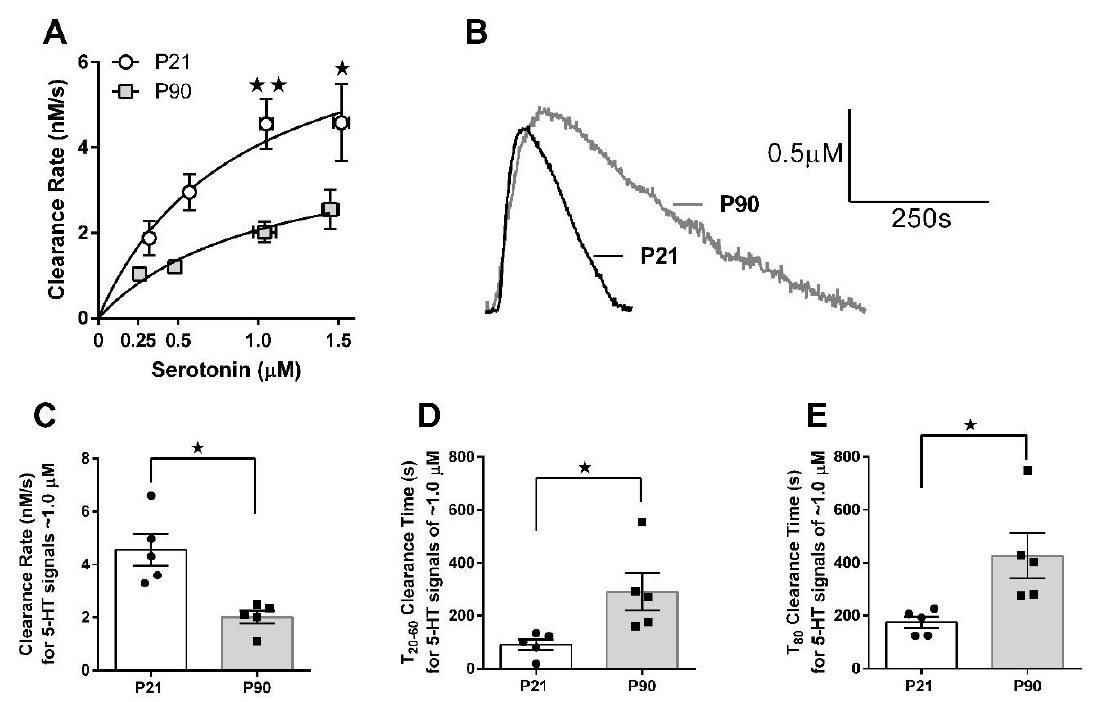
Figure 2. Juvenile mice clear serotonin faster from extracellular fluid in CA3 region of hippocampus than adult mice. ( A ) Serotonin clearance rate as a function of increasing extracellular serotonin concentration. Serotonin was intrahippocampally applied to obtain signals with amplitudes of approximately 0.25, 0.50, 1.0 and 1.5 µ M. Horizontal error bars represent variance (S.E.M) in signal amplitudes achieved. Vertical error bars are S.E.M. for clearance rate. Where error bars are not visible, they are obscured by the symbol. ( B ) Representative traces of serotonin clearance in juvenile (P21, circles) and adult (P90, squares) mice for signal amplitudes of ~1.0 µ M. Summary data for serotonin clearance rate (nM/s) ( C ), T 20–60 clearance time (s) ( D ) and T 80 clearance time (s) ( E ) for signal amplitudes of ~1.0 µ M. ( A ) * p < 0.05, ** p < 0.01 P21 significantly different from P90 mice, 2-way repeated measures ANOVA with Bonferroni’s post-hoc comparisons. ( C – E ) * p < 0.05, unpaired t -tests with Welch’s correction for significantly different variances in D and E. Data are mean ± S.E.M. n = 5 per